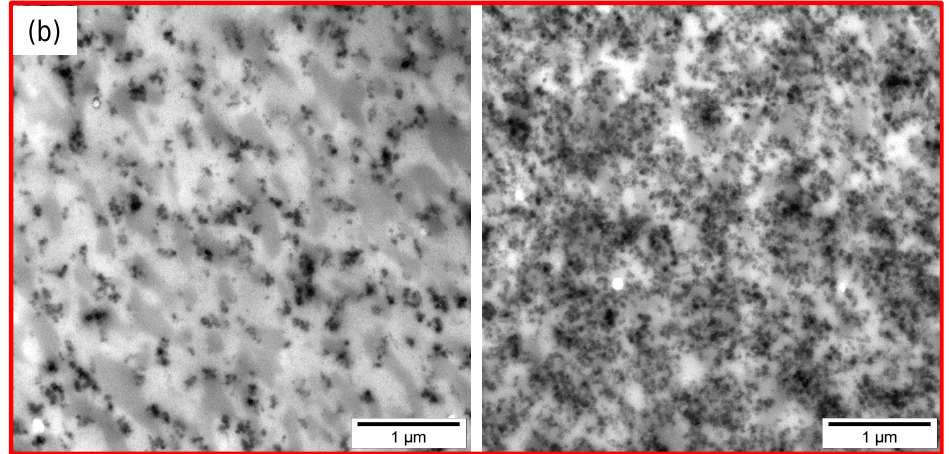
Figure 5. TEM micrograph ( a ) NR composites containing 4.5 and 16 vol.% CB as well as ( b ) NR-BR composites containing 4.5, 15 vol.%. Dark gray domains of BR domains are dispersed in light gray NR matrix .